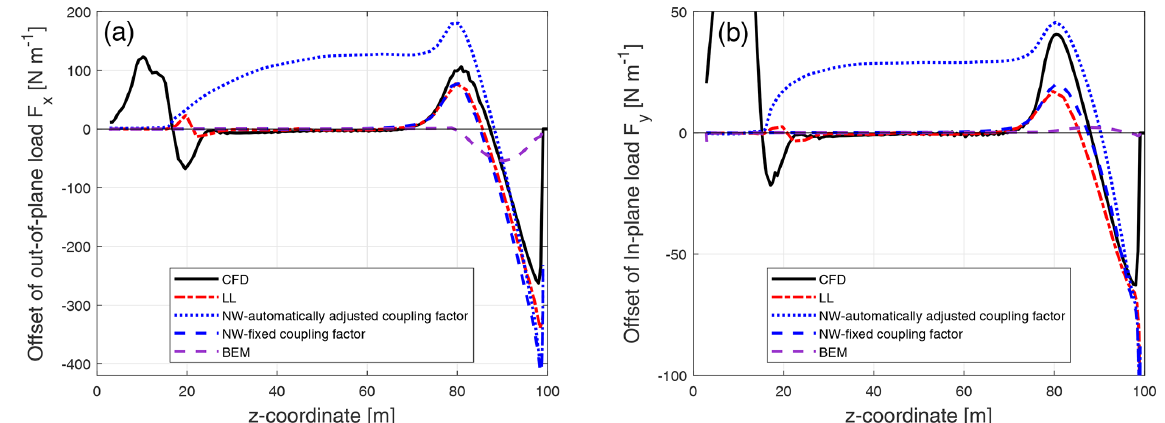
Figure C5. Comparison of the difference between the out-of-plane load (a) and the in-plane load (b) of the forward swept Blade-6 with respect to the baseline blade calculated from the Navier–Stokes solver (CFD), the lifting-line method (LL), the proposed coupled method (NW) and the blade element momentum method